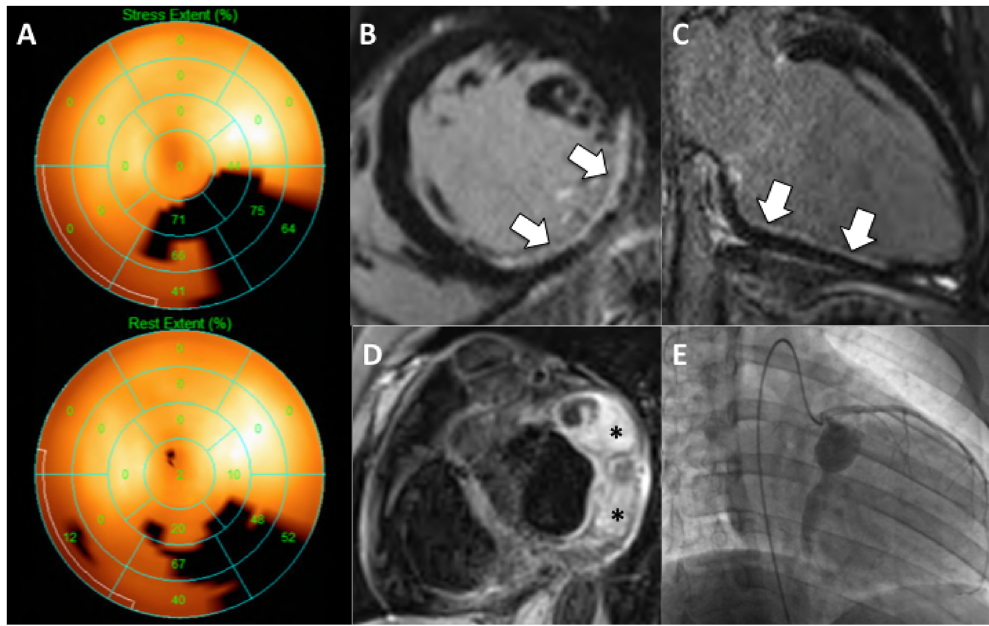
Figure2.Circumflexterritoryinfarct. A)NuclearSPECTperfusionstudydemonstratingalargelyfixedinfero-lateral defect on polar map. B,C) Late gadolinium enhancement reveals a non-transmural scar (white arrows) in